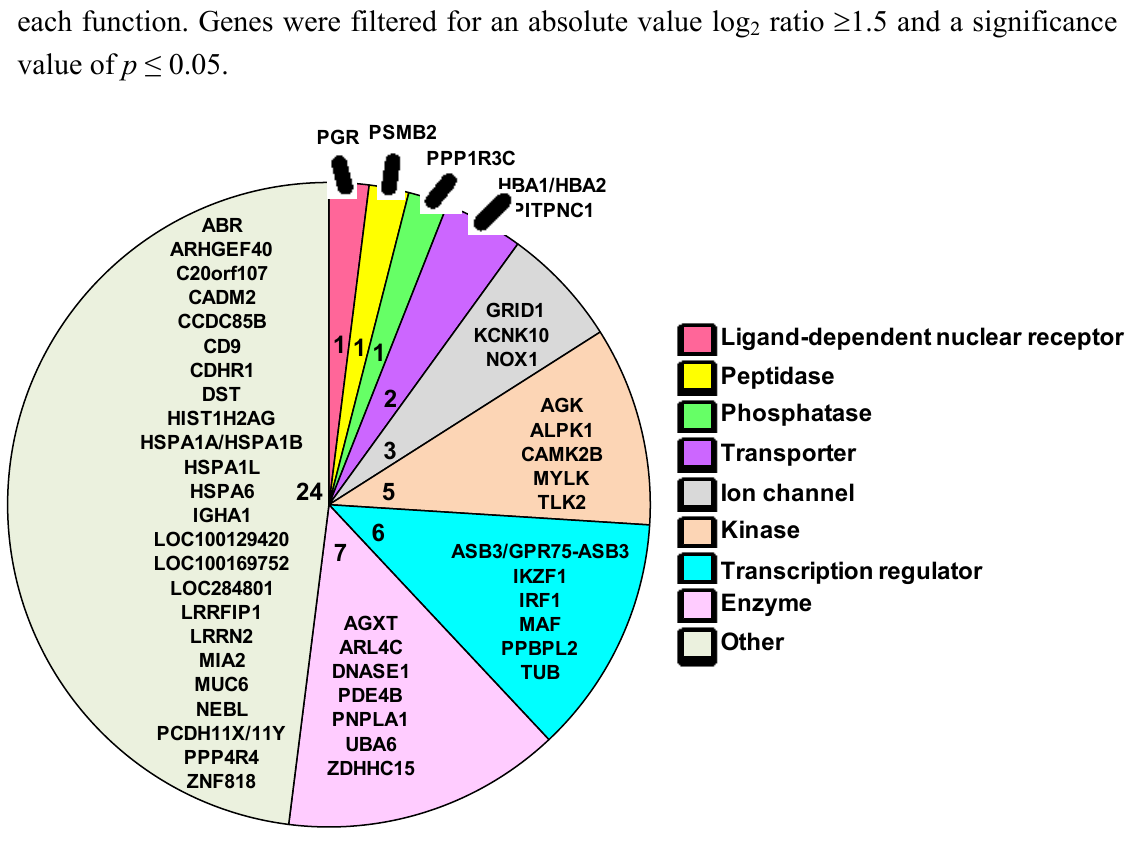
ratio  1.5 and a significance 2